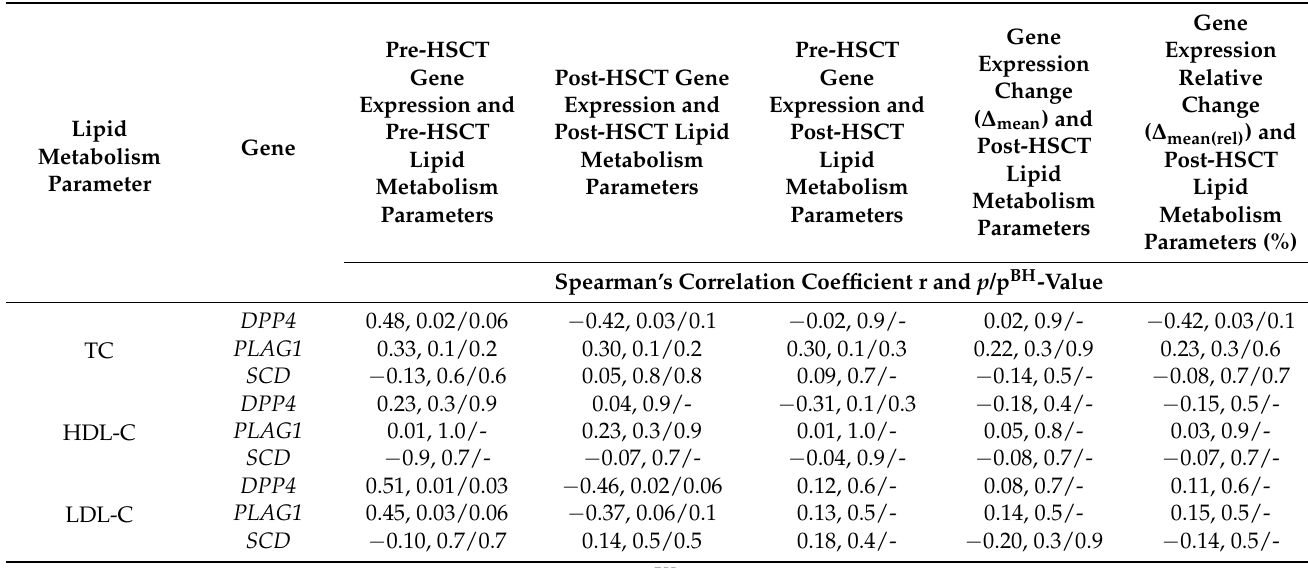
Table 7. Selected correlations between expressions (or its change ∆ mean and relative change ∆ mean(rel) ) of genes associated with lipid metabolism and lipid parameters in children treated with HSCT.